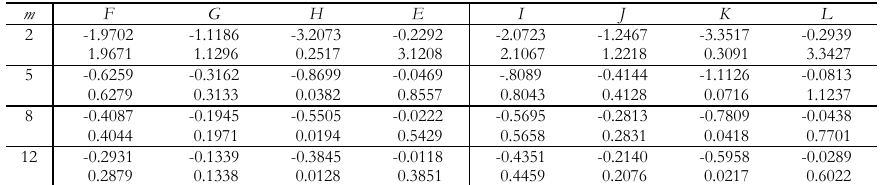
The upper and lower quantiles of F, G, H, E, I, J, K and L when 5 n  and 0.05  